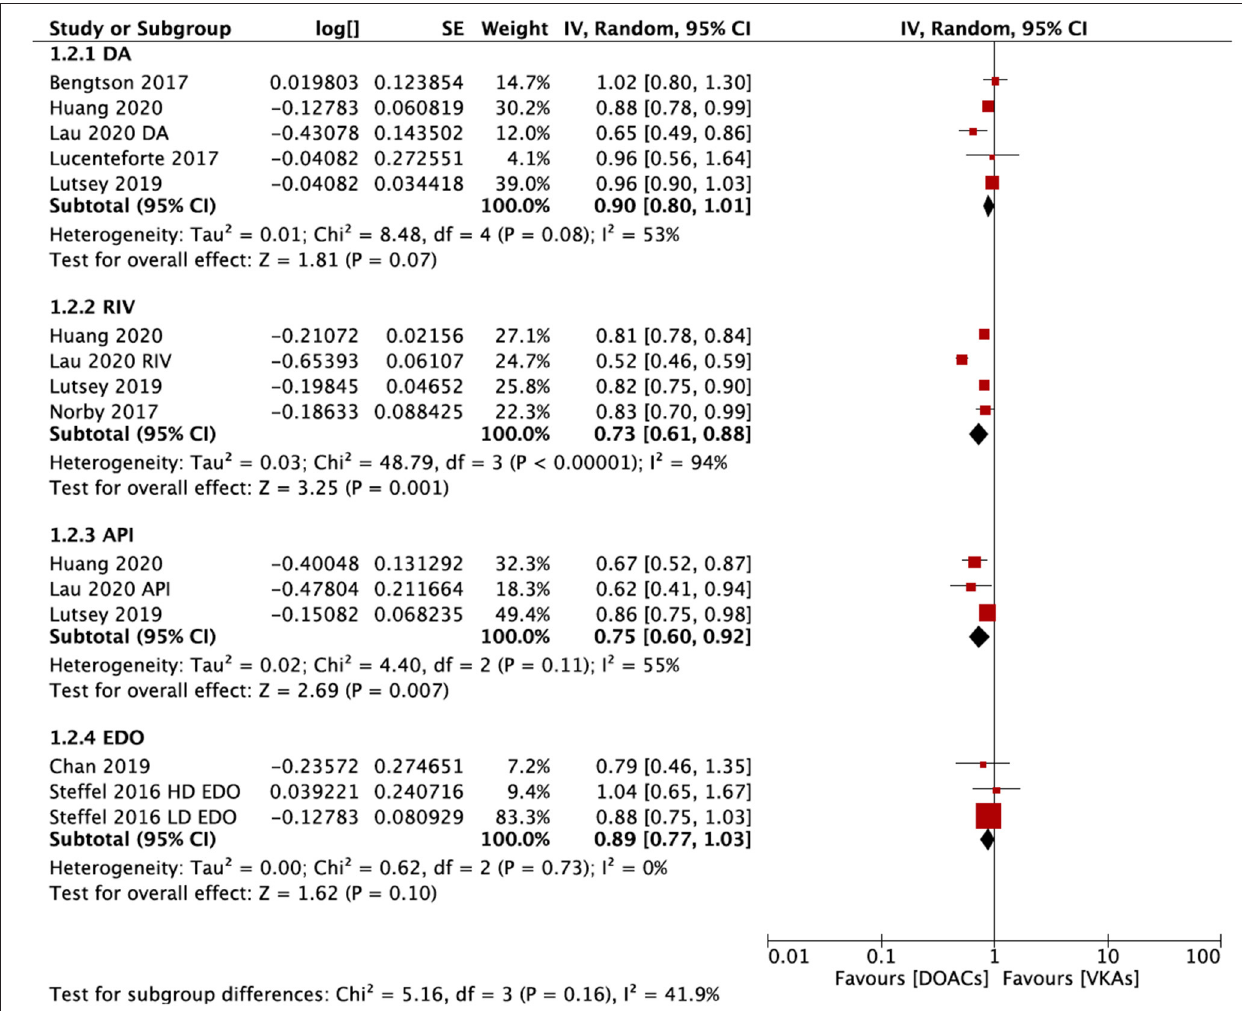
FIGURE 2 | Subgroup analysis based on different types of DOACs regarding the risk of fractures of DOACs vs. VKAs in AF patients. AF, atrial fibrillation; DOACs, direct oral anticoagulants; VKAs, vitamin K antagonists; DA, dabigatran; RIV, rivaroxaban; API, apixaban; EDO, edoxaban; CI, confidence interval; SE, standard error; IV, inverse of the